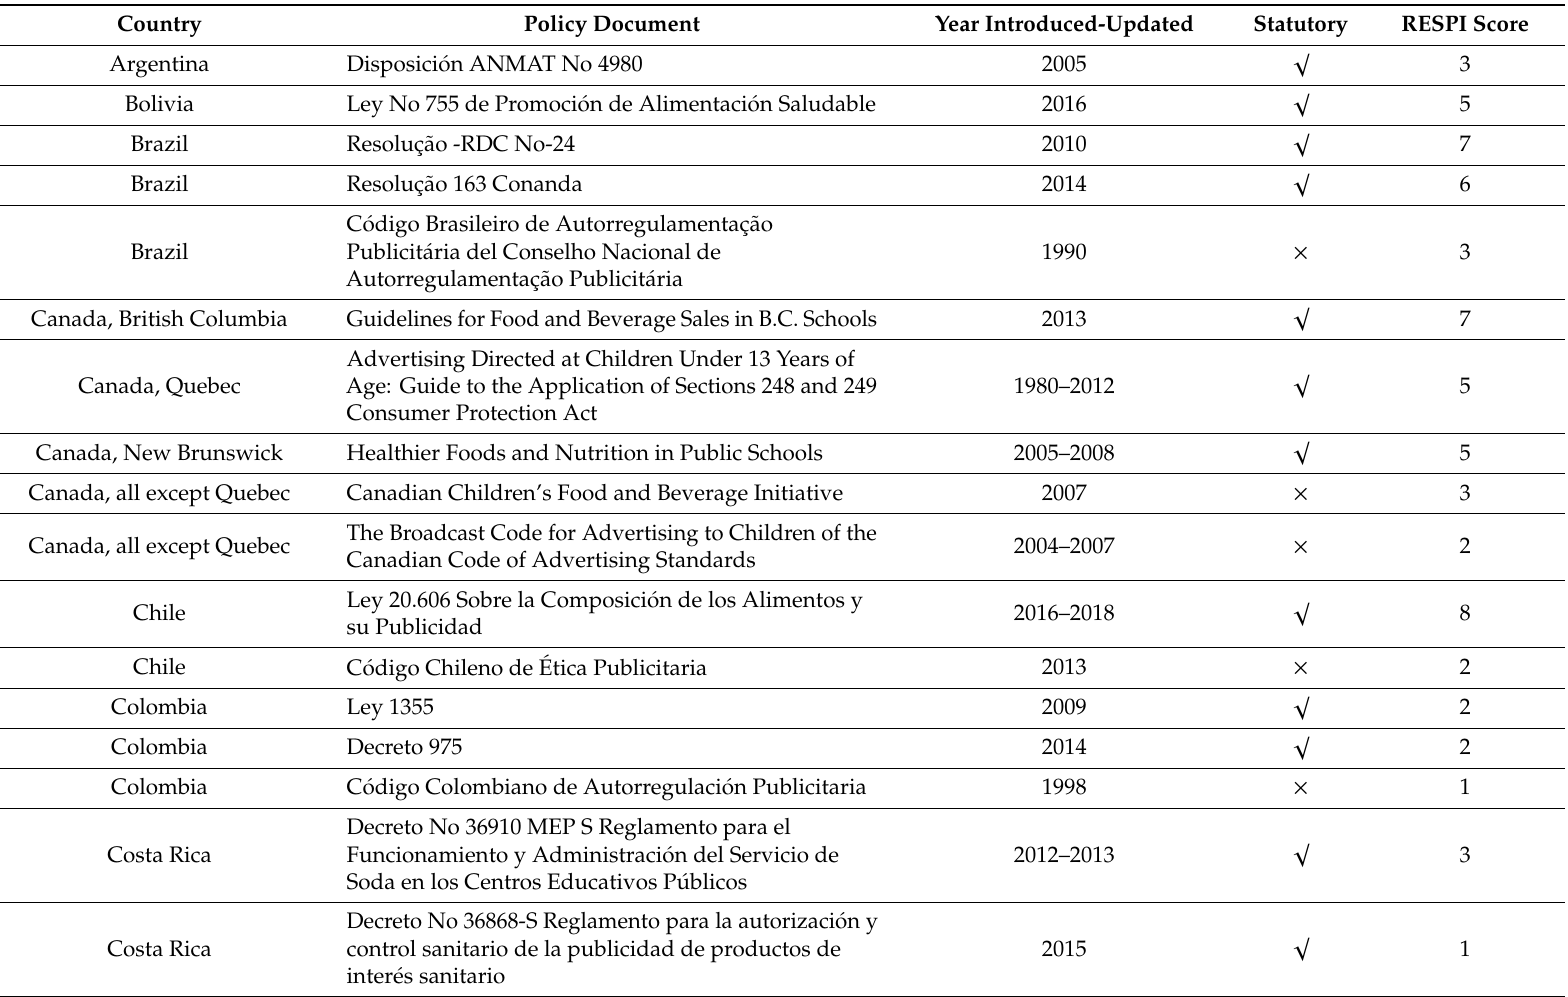
Table 3. Policies to restrict the marketing of HFSS ** food and beverage products to children in 14 countries of the WHO Americas Region *, 1990–2019.